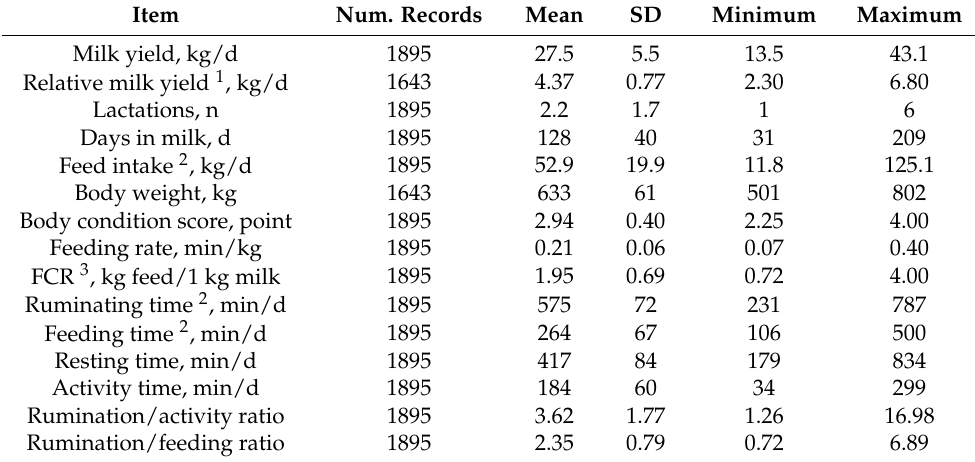
Table 1. Evaluated parameters (dependent variables). Item Num. Records